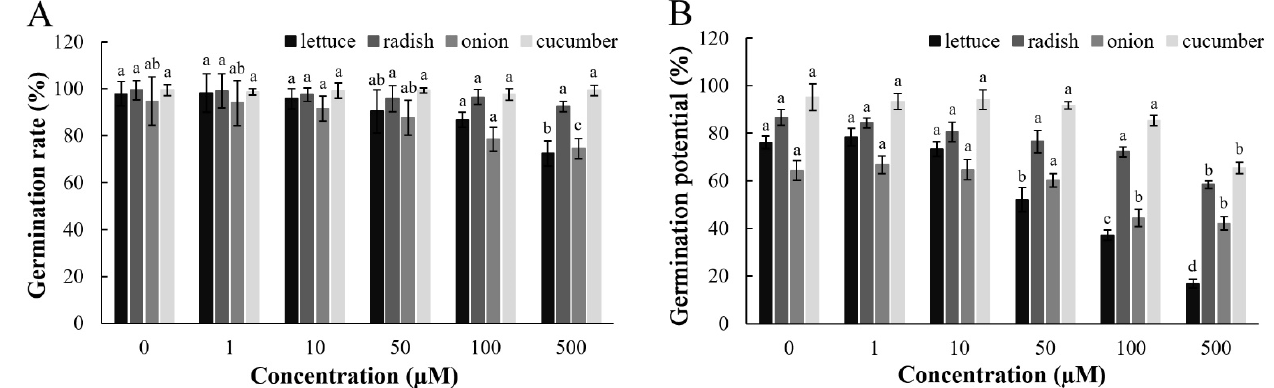
Figure 1. Germination rate ( A ) and germination potential ( B ) of four vegetable seeds under treatments with acacetin. The results presented are the mean of three replicates ± SE, different letters denote significant differences at p < 0.05 according to one-way ANOVA with an LSD test.